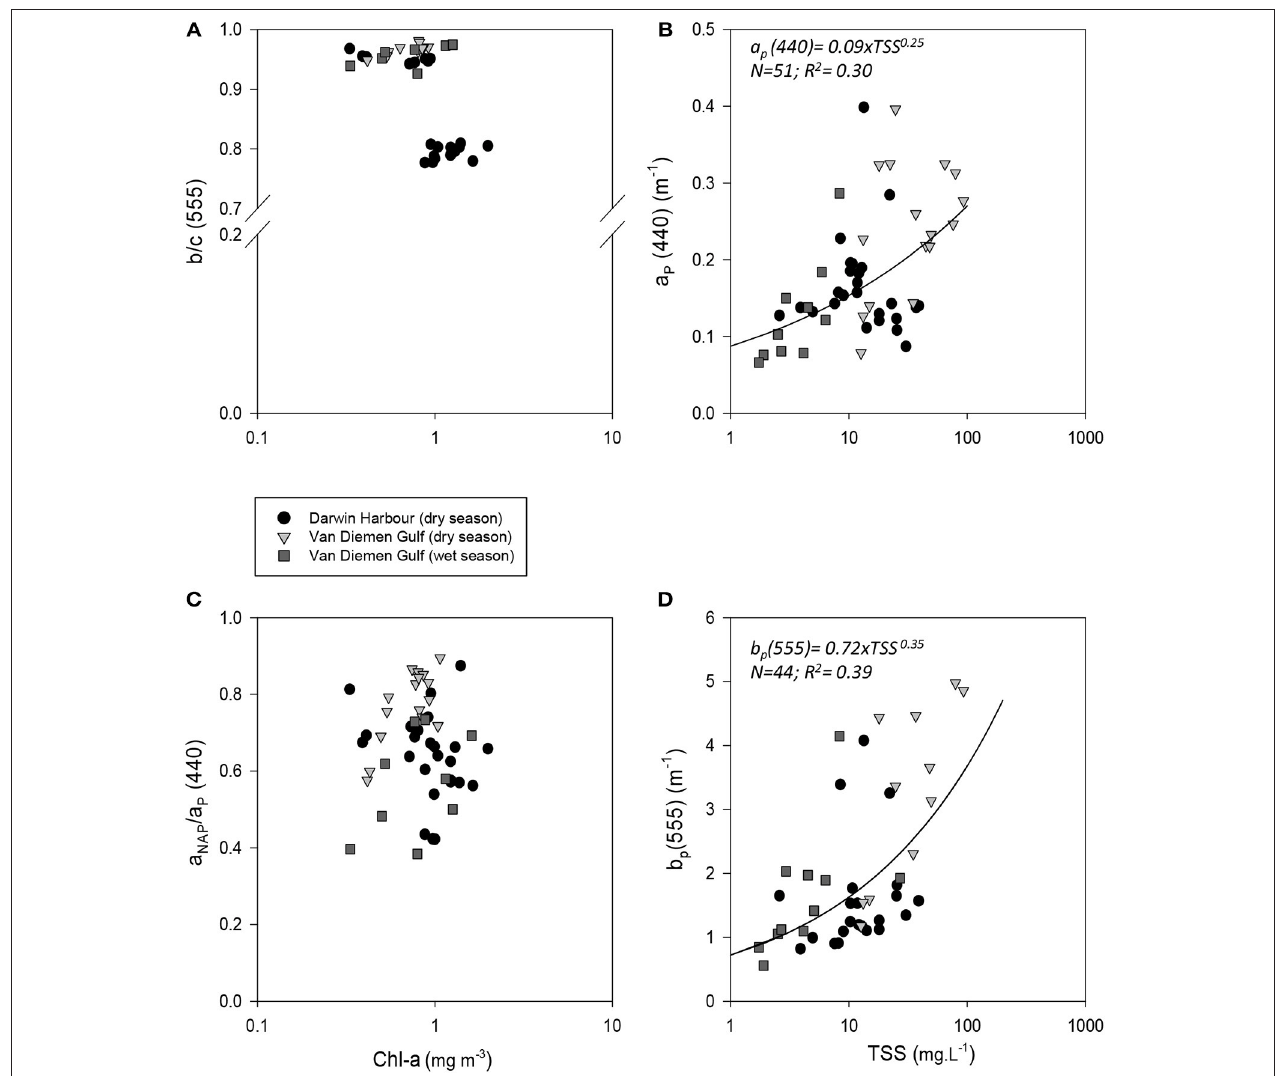
FIGURE 9 | Relationships between (A) b/c(555) and Chl-a; (B) a p (440) and TSS; (C) proportion of non-algal particulate absorption to particulate absorption as a function of Chl-a and (D) b p (555) and TSS.